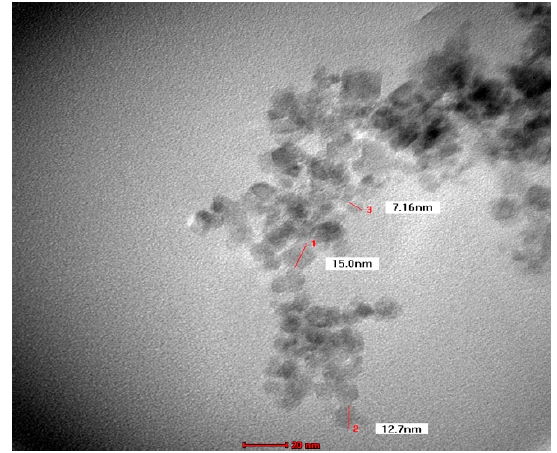
Figure 4. TEM micrograph of biosynthesized iron oxide nanoparticles.